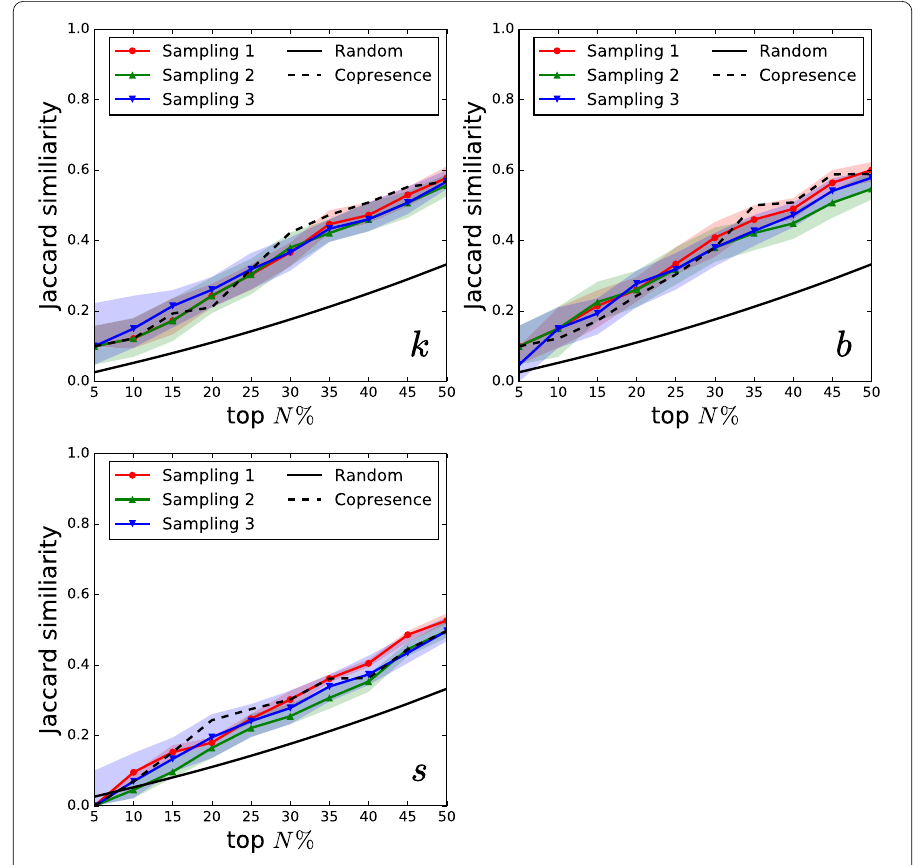
Figure 7 Node ranking similarity. InVS15 data set. We plot for each co-presence sampling method the Jaccard similarity between the top N % nodes in the real and surrogate contact data, when ranked according to their degree k , their strength s or their betweenness centrality b vs. N . The plot shows the median similarity and the shaded areas give the 90% confidence interval.